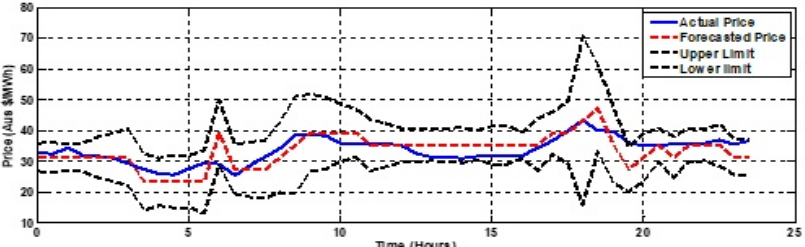
Figure 16. Winter weekdays plot of Tuesday (7 July 2015) with selected features with a MAPE of 6.03.